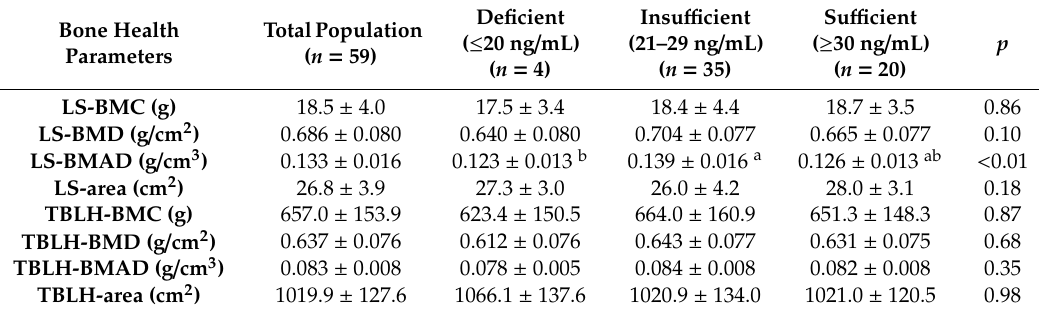
Table 3. Bone health parameters of participants in relation to vitamin D status.